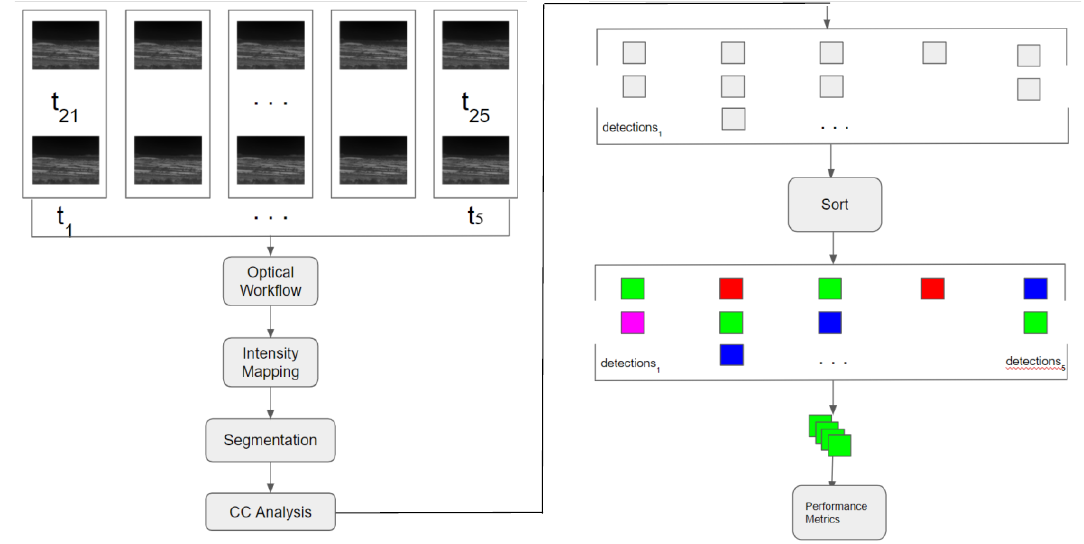
Figure 3. Example of how the proposed workflow generates detections. The color coding after Simple Online and Real-time Tracking (SORT) is used as a visual representation of the different tracking identities (IDs) assigned to each detection.